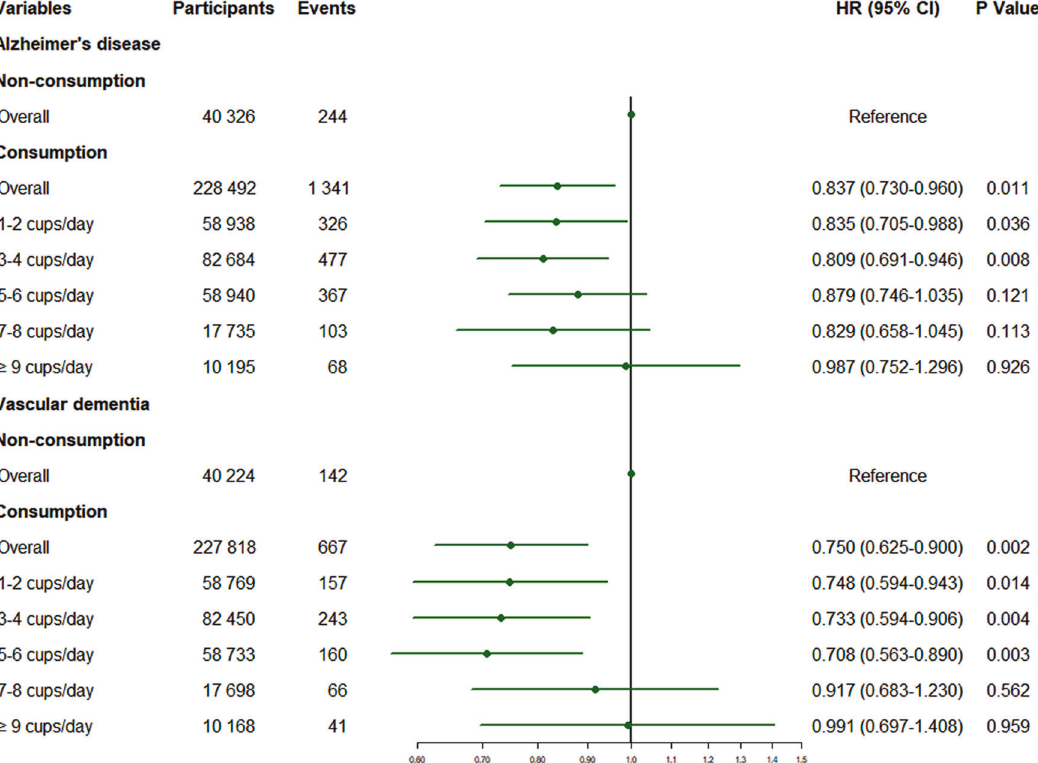
Fig. 3 Associations of tea consumption with risks of AD and VD in the fully-adjusted model. After adjusting for all covariates, participants who consumed 1 – 4 cups of tea a day were 16 – 19% less likely to develop AD compared with non-drinkers. Besides, the tea consumption of 1 – 6 cups/day brought a 25 to 29% reduction in VD incidence. P values were computed by Cox proportional hazard regressions. Covariates included age, sex, ethnicity, TDI, education, BMI, typical sleep duration, smoking status, alcohol status, total consumption of vegetables, total consumption of fruit, total consumption of fi sh and APOE4 status. HR Hazard ratios, CI Con fi dence interval, AD Alzheimer disease, VD Vascular dementia, TDI Townsend deprivation index, BMI Body mass index, APOE4 apolipoprotein E4